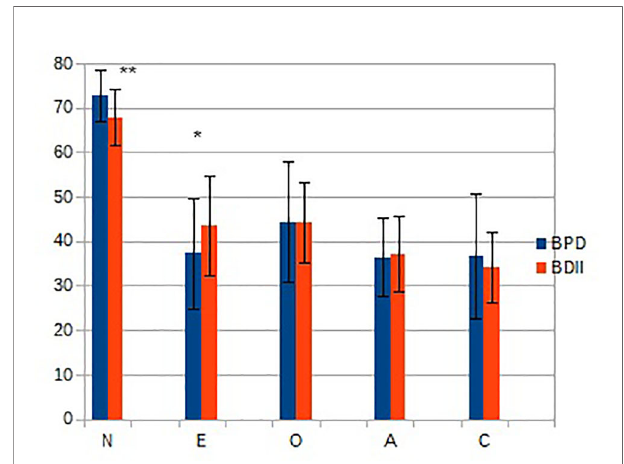
FIGURE 1 | Personality traits scores (mean ± SD) in the two groups of patients. BPD, Borderline Personality Disorder; BDII, type-II Bipolar Disorder. * p < 0.05; ** p < 0.01. N, neuroticism; E, extraversion; O, openness; A, agreeableness; C,